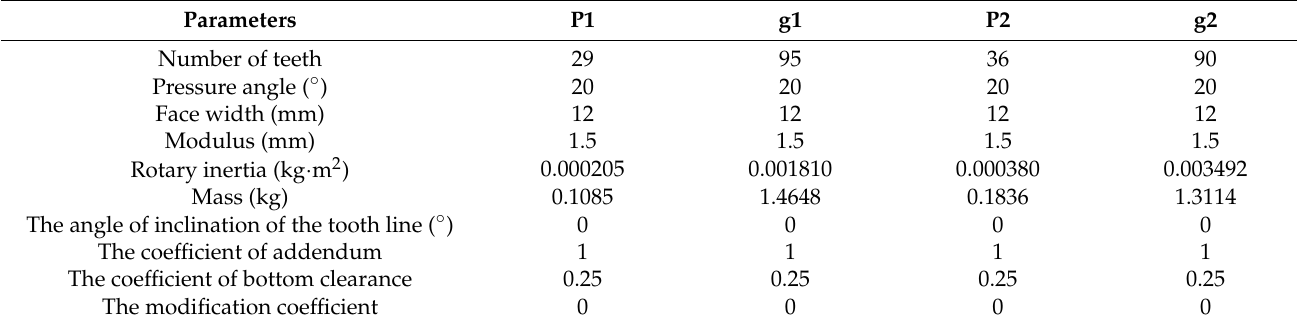
Table 3. Gear parameters of system.